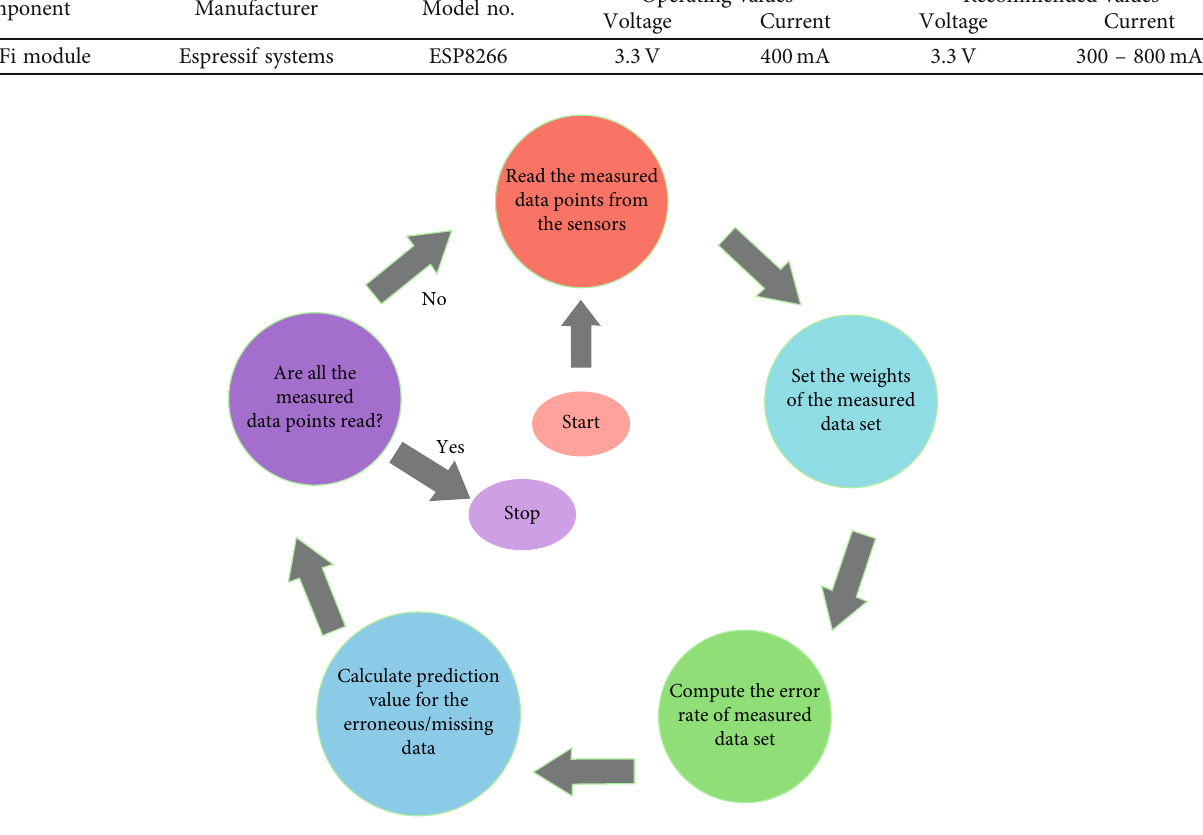
Figure 4: Prediction process of erroneous/missing